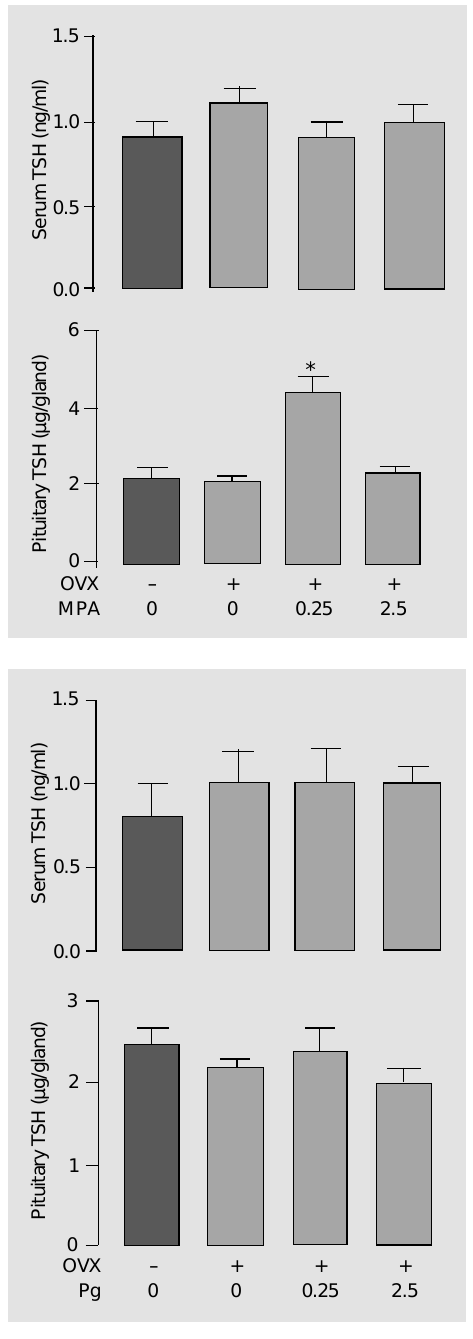
Figure 1 - Serum and pituitary TSH of young adult (3 months old) sham-operated or ovariecto- mized (OVX) rats treated with medroxyprogesterone acetate (MPA, 0.25 or 2.5 mg/100 g body weight) or saline, sc , for 9 days before sacrifice. Values are reported as mean ±